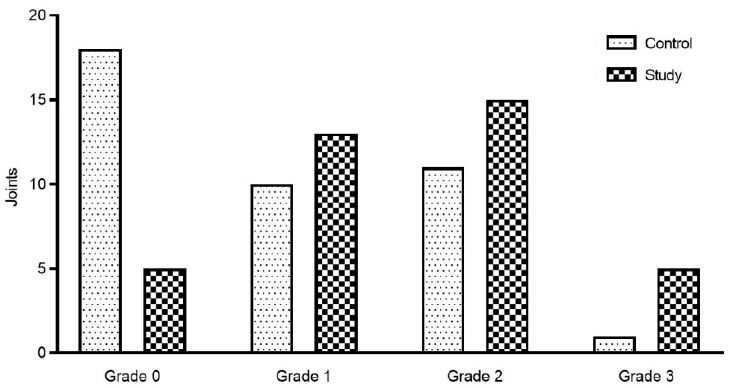
Figure 5. Joint effusion between the study group and the control group. The statistical results: Z = − 2.974, p = 0.003.